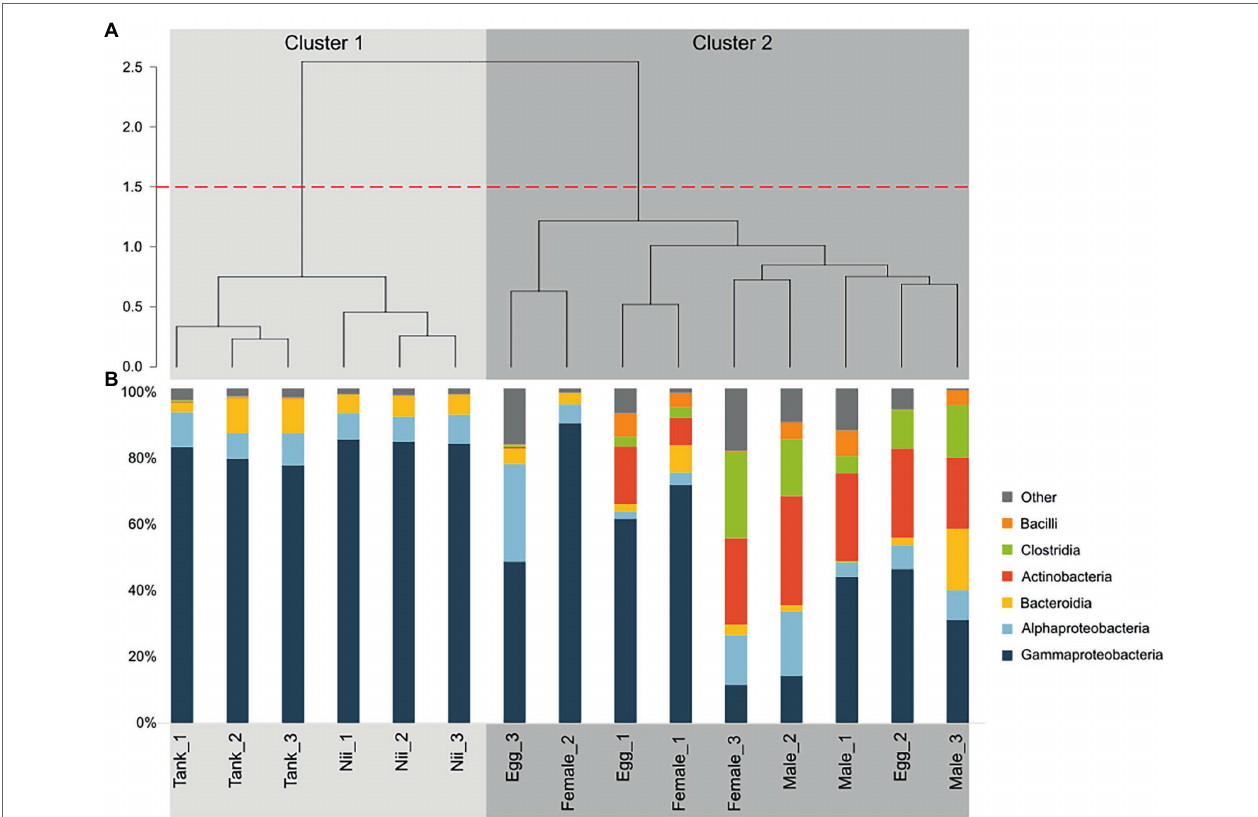
FIGURE 2 | Clustering and total microbial composition of all the samples. (A) Hierarchical clustering based on Bray–Curtis dissimilarity and Ward method. Clusters were defined using a 1.5 threshold depicted by the red dotted line. All the tank water and the nauplius (nii) samples are gathered in Cluster 1, in light gray. All the female, the male and the egg samples are clustered in Cluster 2, in dark gray. (B) Bacterial compositions of the tank water, the nauplius (nii), the egg, the female and the male samples. Major bacterial classes were defined as the bacterial classes with a total relative abundance higher than